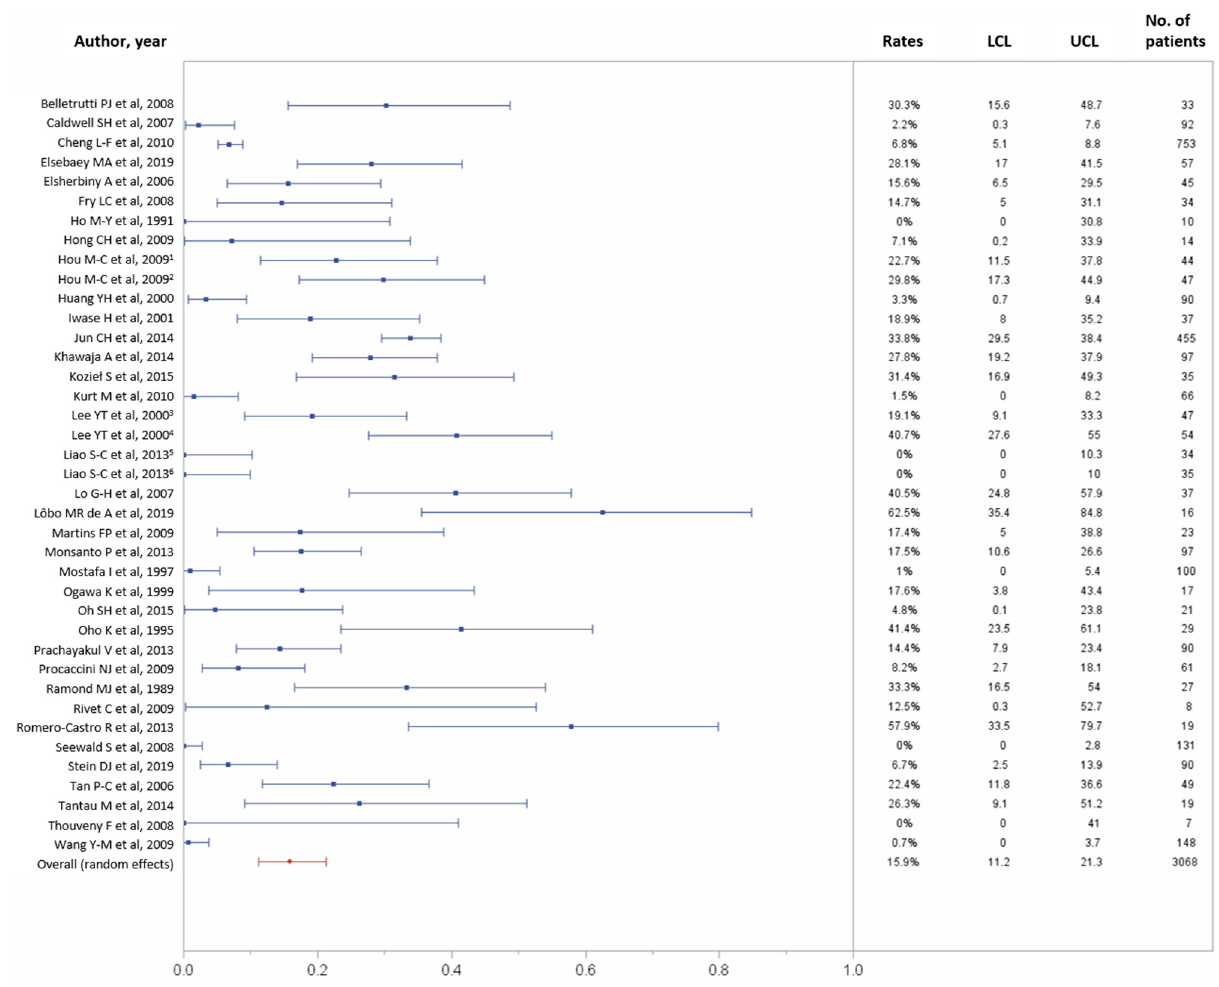
Figure 5. Forest plots of the 30-day overall complications rates. Overall rate (random effects model): 15.9% (95% CI, 11.2–21.3%); heterogeneity: Q = 505.22, p < 0.0001, I 2 = 92.48%; UCL, upper control limit; LCL, lower control limit; No, number.